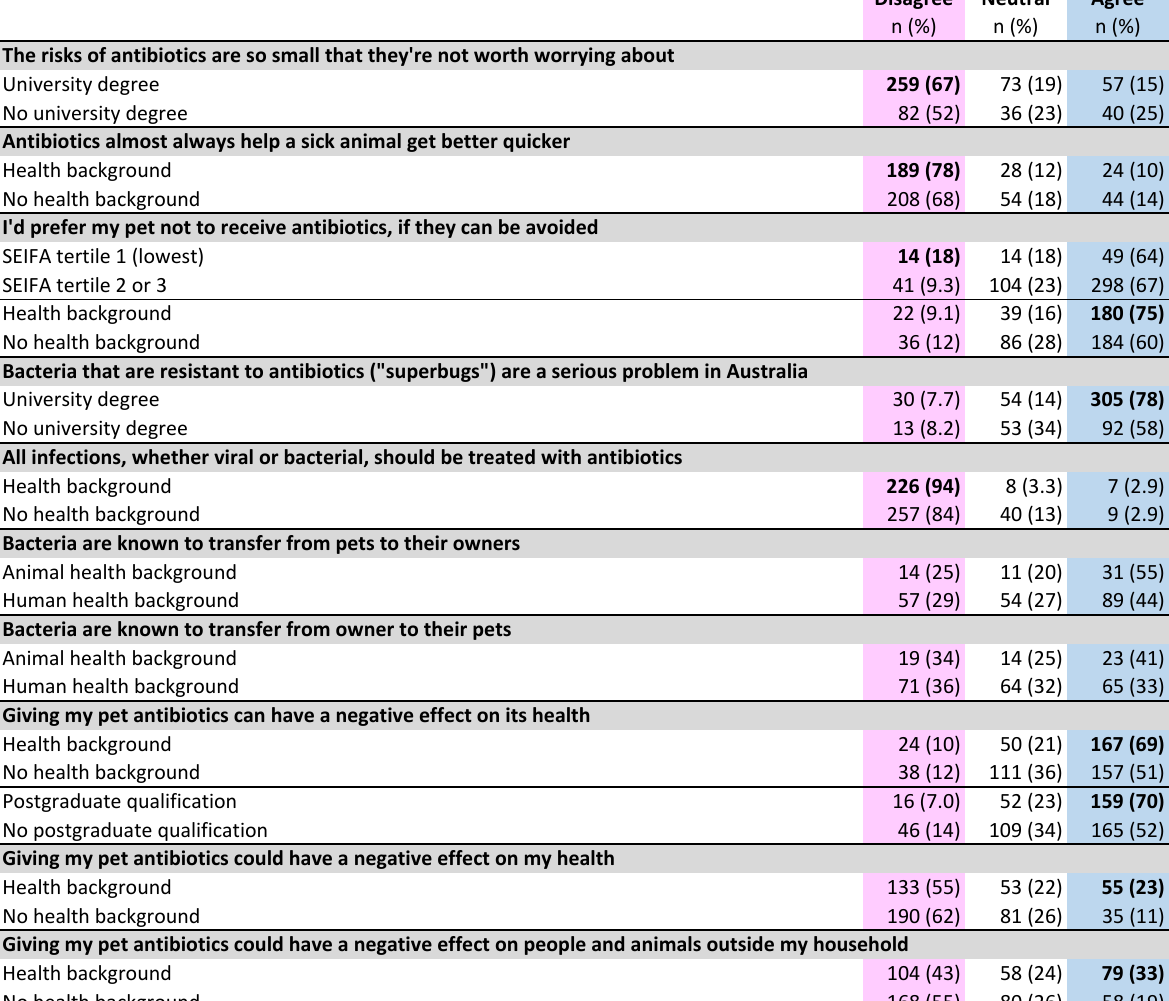
Figure 9. Differences by respondent demographic category in pet owner opinions for antibiotic use, knowledge of microbiology and antibiotic resistance. Bold type indicates a significantly higher subgroup result ( p <